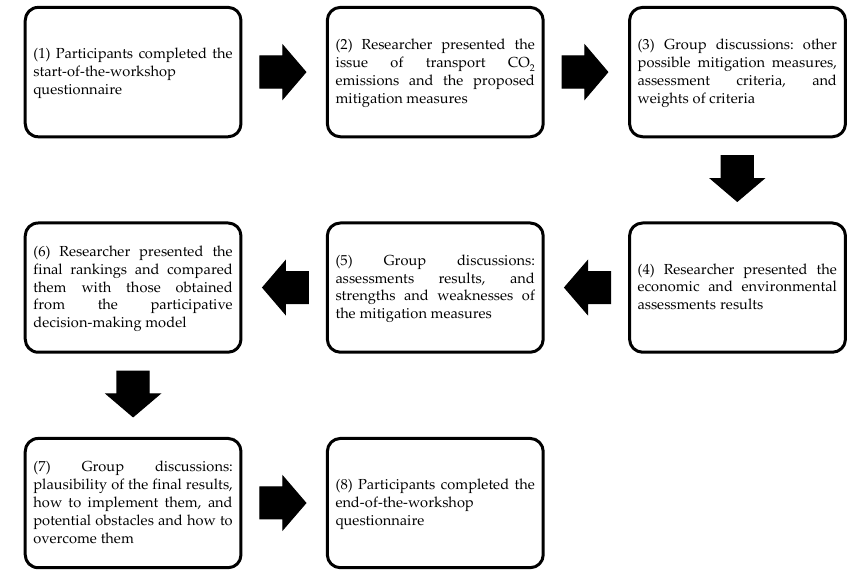
Figure 2. Flow of the workshops.